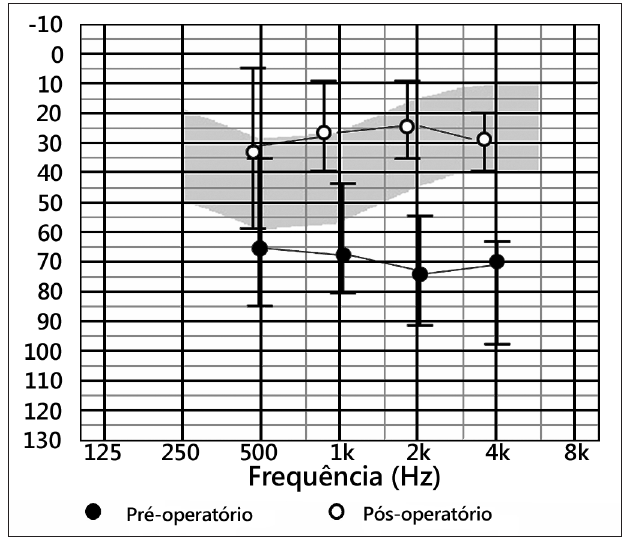
Figura 1. Limiares pré e pós-operatórios – limiares médios em audio- gramas pré e pós-operatórios.